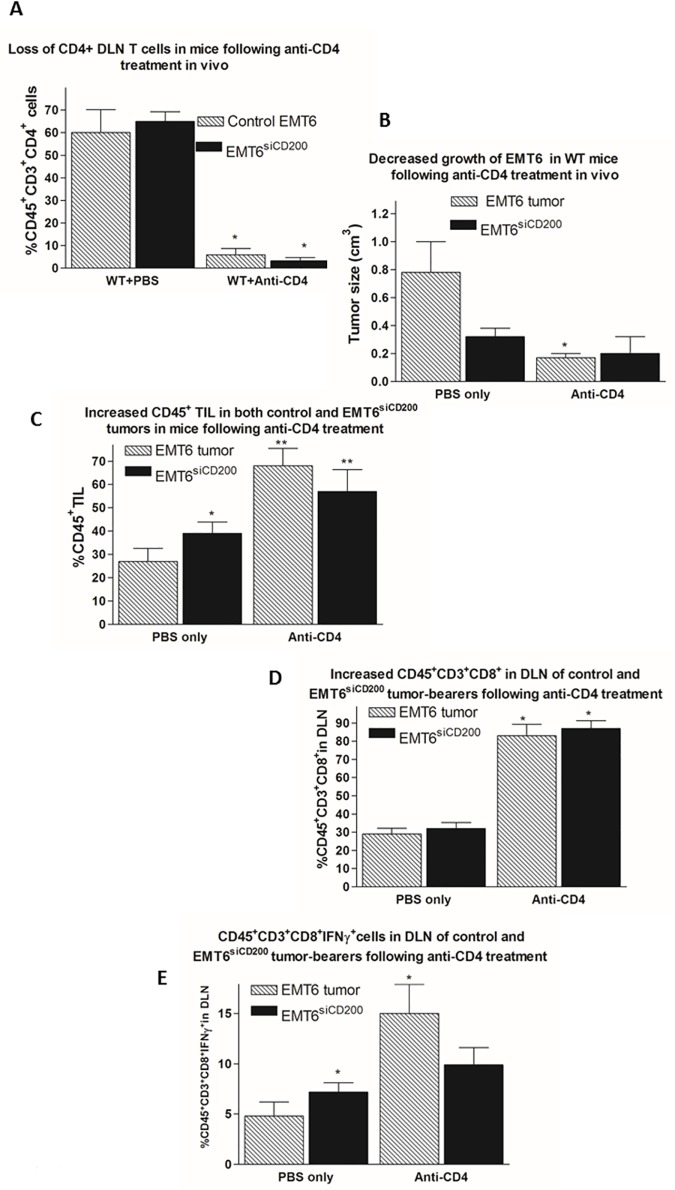
Effect of depletion of CD4+ T cells in EMT6 and EMT6siCD200 tumor bearing WT mice.All data show represent means (±SD) of 5 mice/group unless otherwise stated. A. Single cell suspensions of DLN from EMT6 and EMT6siCD200 tumor bearing mice (day 19 of sacrifice) treated with anti-CD4 or PBS were stained for CD45, CD3, and CD4 cell surface expression. *p<0.05, compared with respective PBS control. B. Tumor size in mice in experiments of the type shown in panel A-data pooled from 2 studies. *p<0.05, compared with respective PBS control. C. EMT6 and EMT6siCD200 tumors were harvested from mice as in panel A. Tumors were digested, stained for CD45 cell-surface expression, and analyzed by flow cytometry. *p<0.05, compared with respective with control EMT6 in PBS treated mice; ** p<0.05 compared with respective PBS control. D. Single cell suspensions of DLN from EMT6 and EMT6siCD200 WT tumor bearing mice from panel A were stained for CD45, CD3, and CD8 cell surface expression. *p<0.01, compared with respective PBS control. E. DLN cells from EMT6 and EMT6siCD200 WT tumor bearing mice from panel D were incubated with GolgiPlug for 8 hours and stained with CD45, CD3, and CD8 cell-surface antibodies as well as an anti-IFNγ intracellular antibody. Data show mean (±SD) of 3 mice/group. *p<0.05 compared with PBS treated mice with control EMT6 tumor.